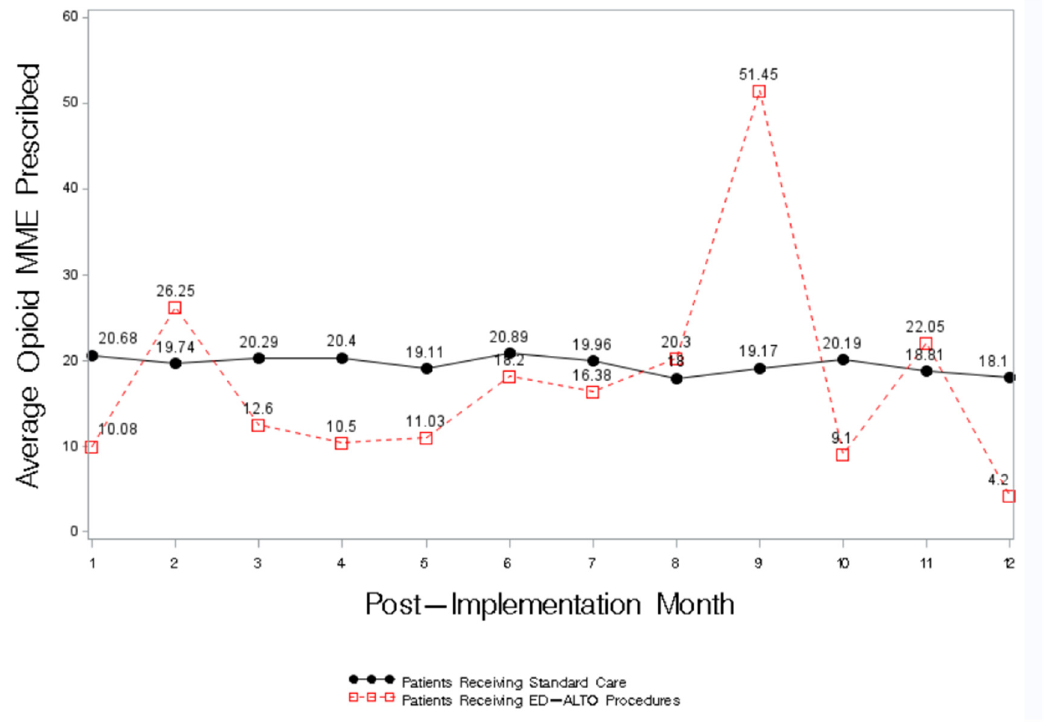
Figure 2. Average Opioid MME prescription by ED-ALTO Procedure Status.